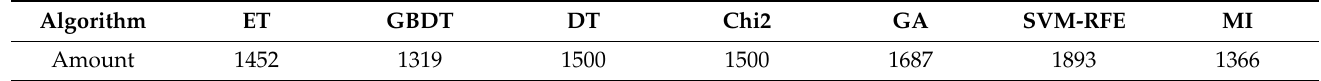
Table 4. The number of features selected by each feature selection